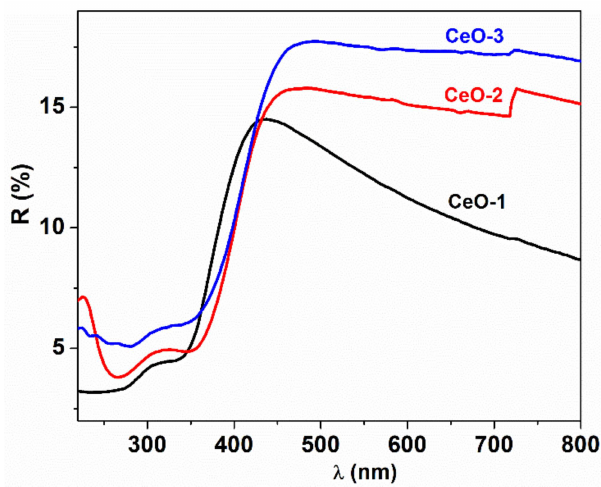
Figure 5. UV-Vis diffuse reflectance spectra of CeO 2